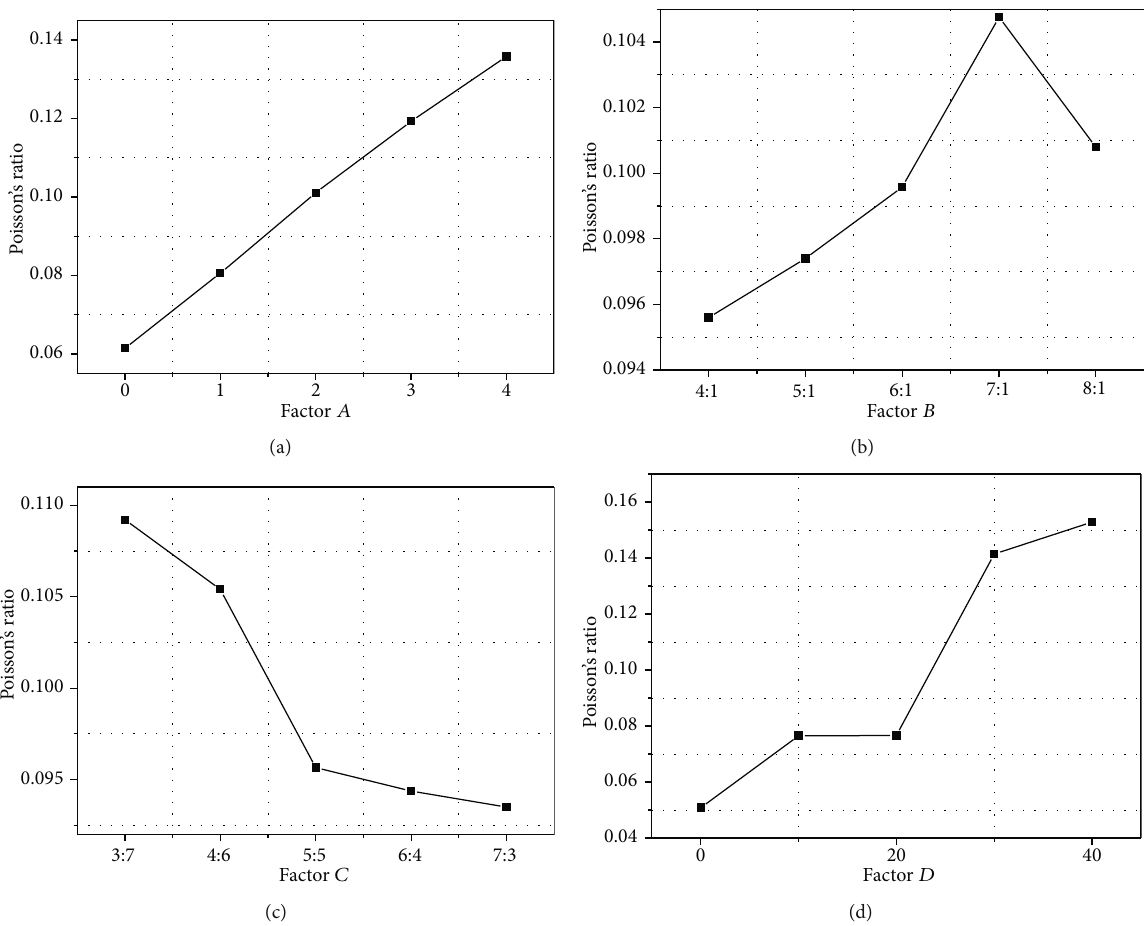
Figure 7: Intuitive analysis chart of Poisson ’ s ratio in fl uencing factors: (a) factor A , (b) factor B , (c) factor C , and (d) factor D